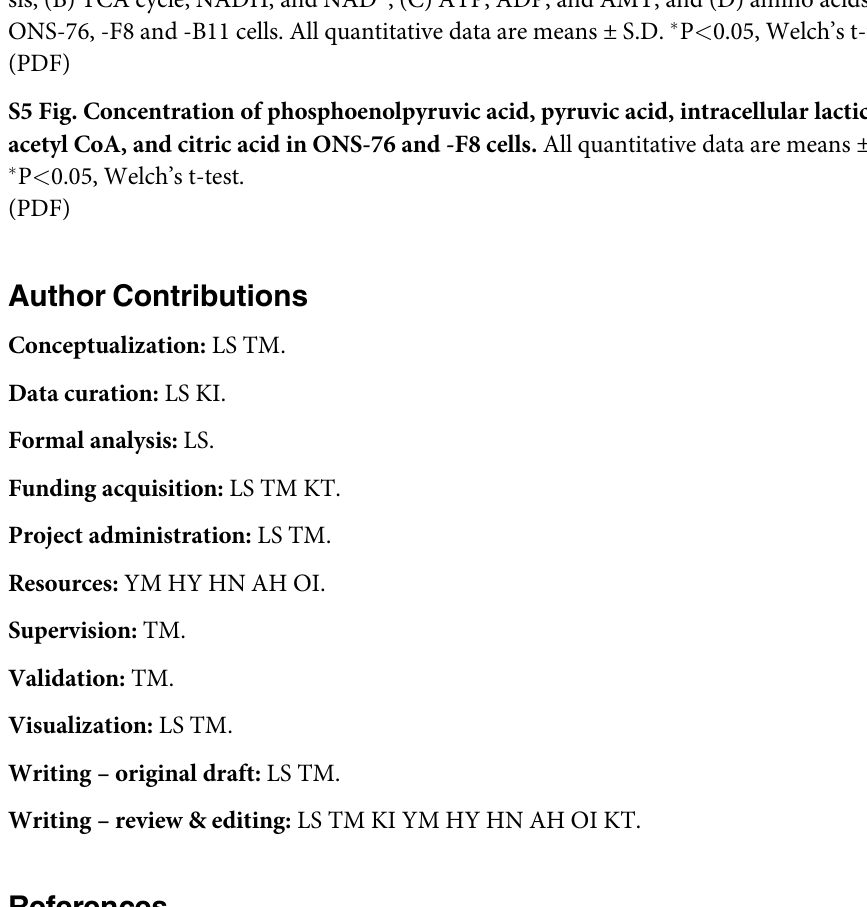
S4 Fig. Metabolome analysis in ONS-76 and -F8 cells with and without DCA. (A) Glycoly- sis, (B) TCA cycle, NADH, and NAD + , (C) ATP, ADP, and AMT, and (D) amino acids in ONS-76, -F8 and -B11 cells. All quantitative data are means ± S.D. (cid:3) P < 0.05, Welch’s t-test. (PDF) S5 Fig. Concentration of phosphoenolpyruvic acid, pyruvic acid, intracellular lactic acid, acetyl CoA, and citric acid in ONS-76 and -F8 cells. All quantitative data are means ± S.D. (cid:3) P < 0.05, Welch’s t-test.